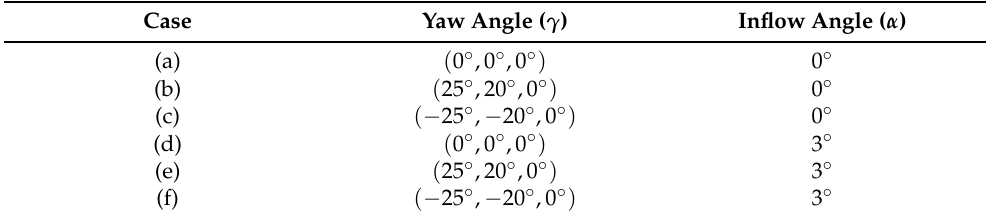
Table 1. Configurations of six representative cases in full-wake and partial-wake